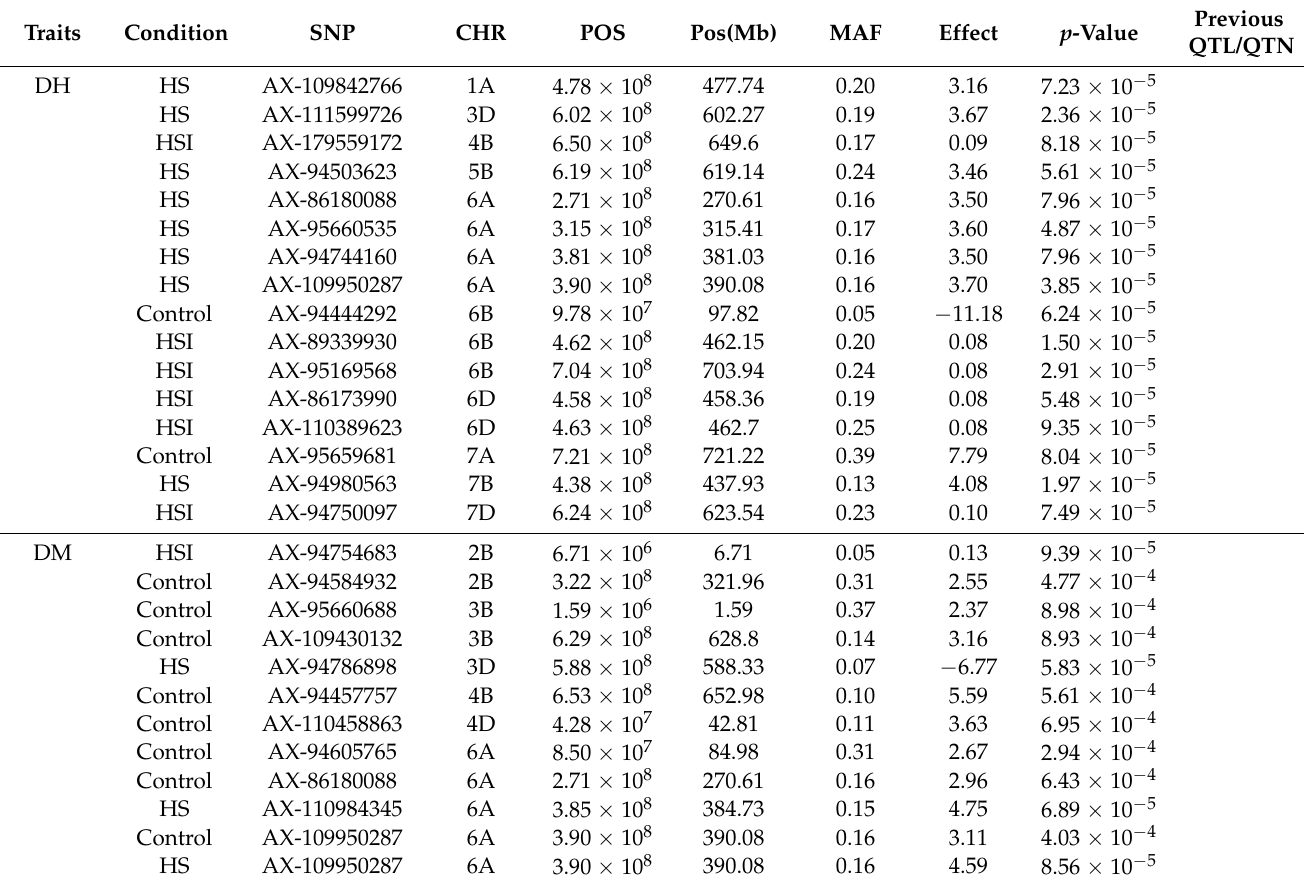
Table 2. QTNs associated with phenotypic traits in control and heat stress (HS) conditions, with chromosome number, position, p -value, and minor allele frequency